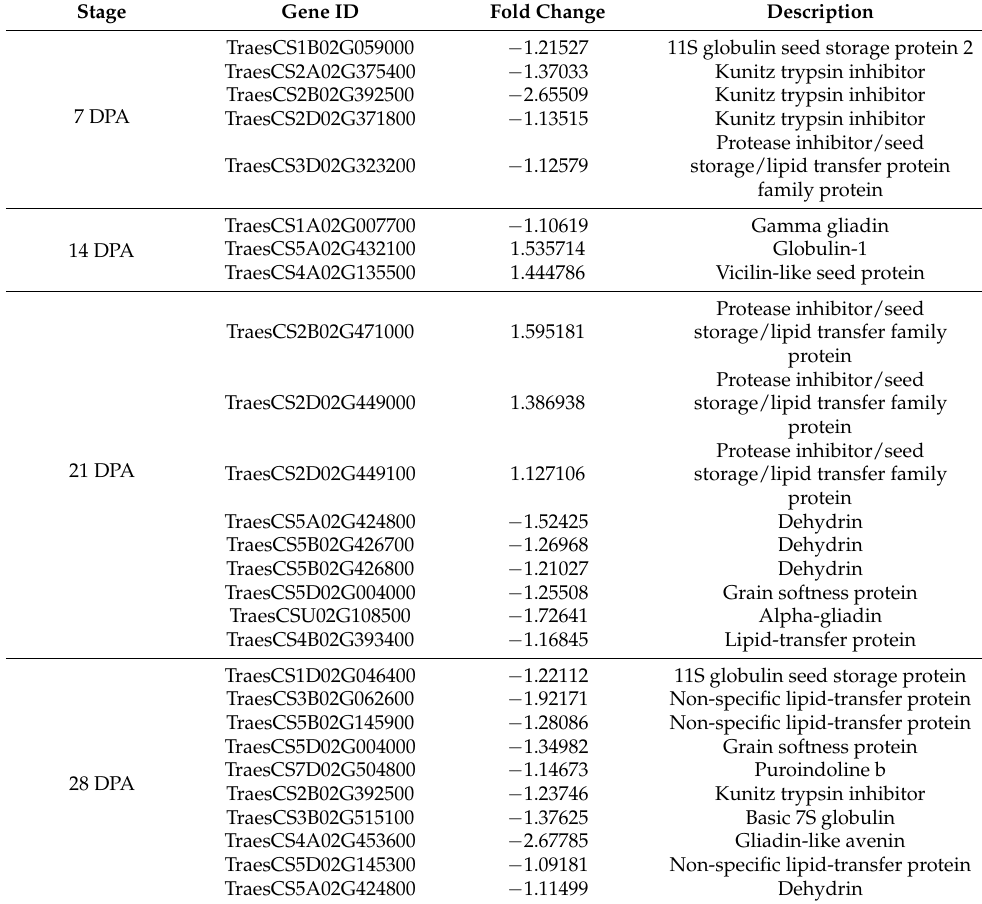
Table 4. Differentially expressed SSPs at different stages in the